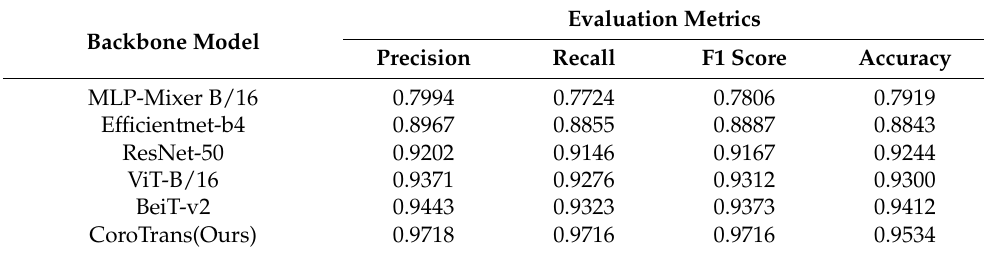
Table 2. Comparison of baseline models and proposed